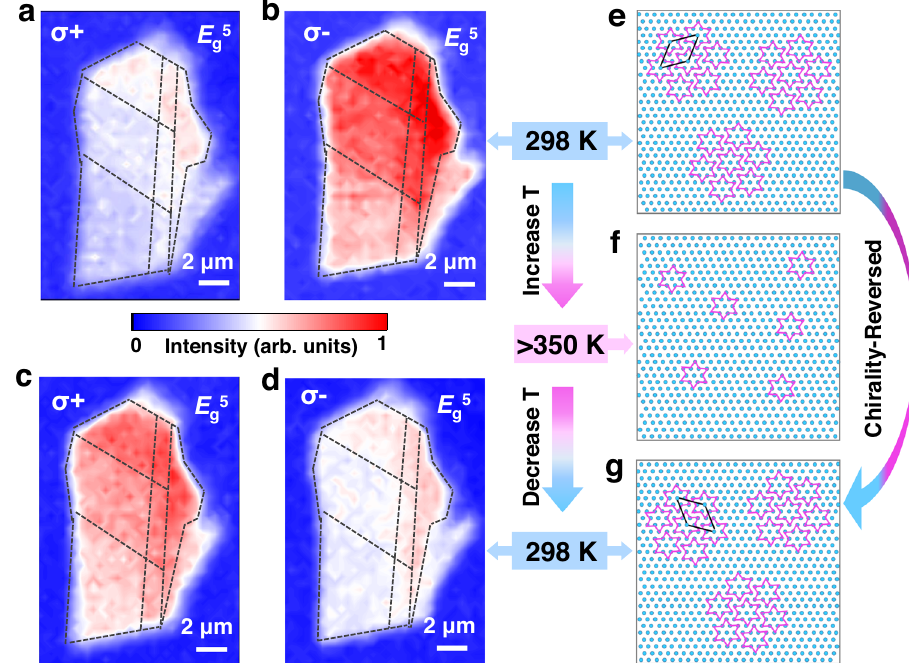
Fig.3|Chiralityswitchingof1T-TaS 2 duringthetemperaturevariationprocess. a , b Ramanintensitymapping imagesforthe E g 5 mode of amultilayer1T-TaS 2 fl ake under a σ + and b σ − excitation at 298K. The dotted lines divide the fl ake into several parts with different thicknesses. c , d Raman intensity mapping images for the E g 5 mode of the chirality-reversed 1T-TaS 2 under c σ + and d σ − excitation after